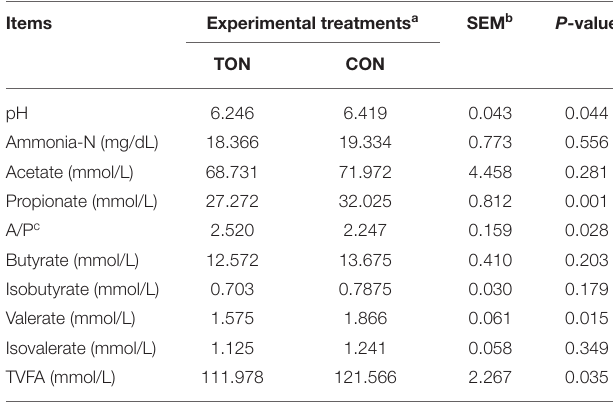
TABLE 3 | Ruminal fermentation parameters in dairy cow showing tongue- rolling behavior or no signs of abnormal behavior.